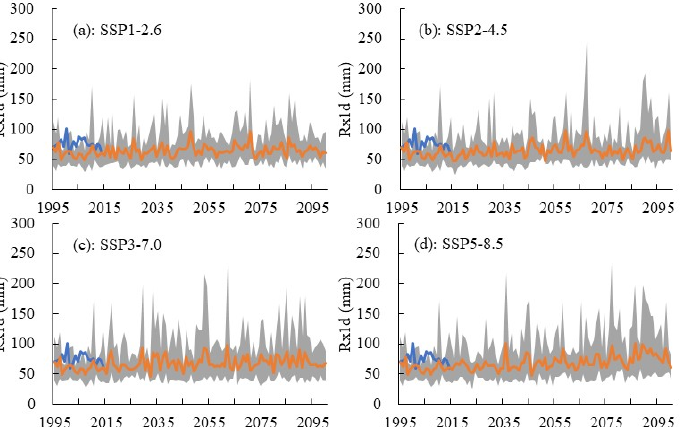
Figure 5. Historical variation and projection trend of Rx1d under SSPs scenarios ( a to d represent SSP1-2.6, SSP2-4.5, SSP3-7.0, and SSP5-8.5 respectively) for the Huai River basin (same to Figure